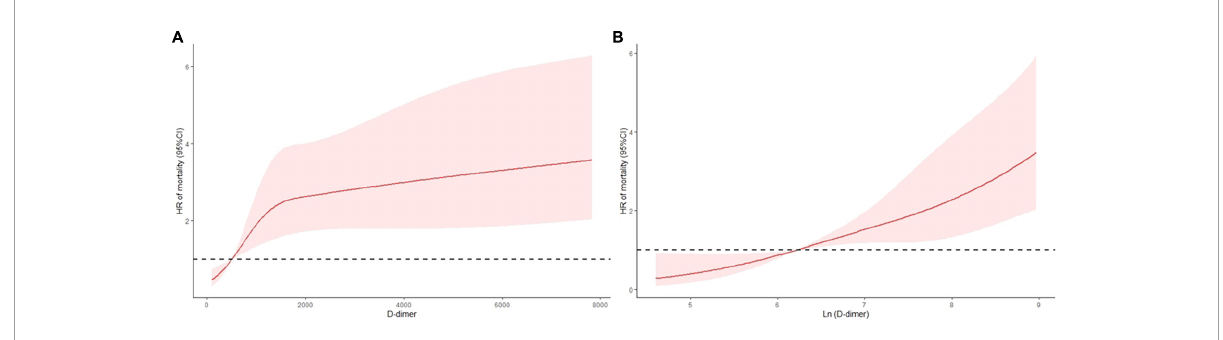
FIGURE1 K-M curves for 30-day all-cause mortality and secondary endpoint events according to low ( < 720 ng/ml), median (720–3,600 ng/ml), and high ( > 3,600 ng/ml) levels of D-dimer. (A) All-cause mortality, (B) secondary endpoint events.